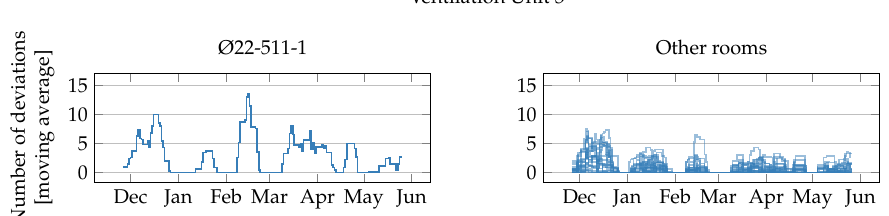
Figure 8. Moving average of deviations for ventilation unit 3. In the first plot, the room which frequently deviate from the common behaviour is shown separately. The rest of the rooms are shown together in the second plot.